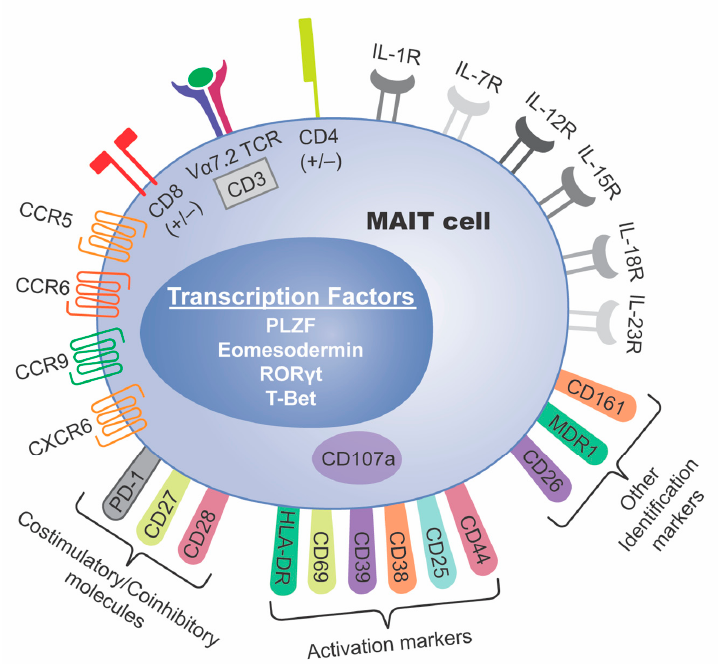
Figure 1. MAIT Cell Identification. A representation of known biologically significant markers found on MAIT cells. Pictured is the V α 7.2 TCR, co-stimulatory molecules CD8(+/ − ), CD3, CD4(+/ − ), CD27, and CD28, coinhibitory and immunotherapy target molecule PD-1, cytokine receptors IL-1R, IL-7R, IL-12R, IL-15R, IL-18R (CD218), and IL-23R, chemokine receptors CCR5, CCR6, CCR9, CXCR6, activation markers HLA-DR, CD69, CD39, CD38, CD25, CD44, and degranulation marker CD107a (intracellular), and other identification markers CD161, MDR1, and CD26. Identification transcription factors include PLZF, Eomesodermin, ROR γ t, and T-Bet. MAIT cells specifically recognize metabolic intermediates generated by microbial ri- boflavin biosynthesis, which play an essential role in MAIT cell development, activation, maintenance, and proliferation. MAIT cells are selected in the thymus on double positive thymocytes in an MR1-dependent fashion, and then proliferate in the periphery when ex- posed to microbial antigens, often from host microbiota [34]. In humans, MAIT cells were first described in the intestinal mucosa and liver [35]; however, they can be found in many other organs, constituting up to 10% of circulating CD8+ T lymphocytes and 5% of total